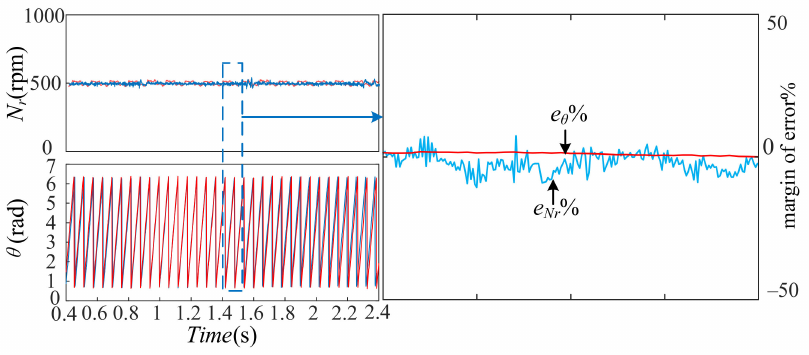
Figure 11. Tracking performances of speed and position under a speed command of 500 rpm (the red line represents the actual value, and the blue line represents the estimated